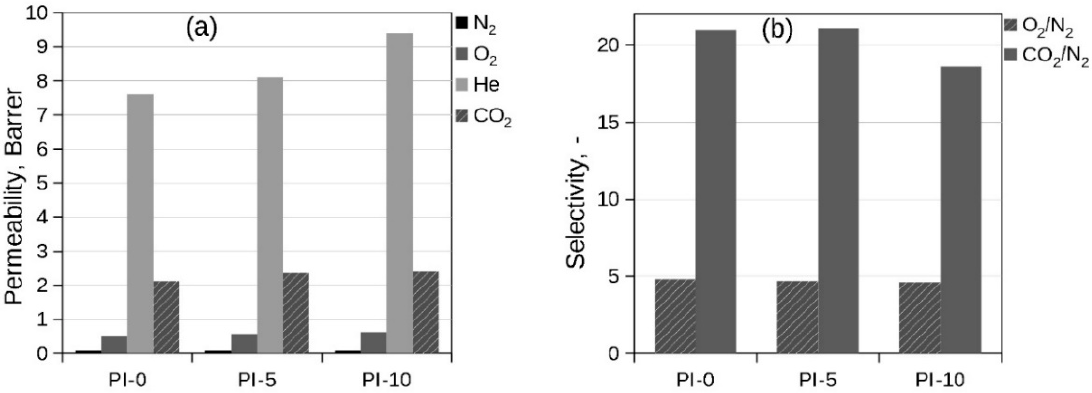
Figure 1. Dependence of the permeability ( a ) and the selectivity ( b ) of PI on silica content of 0% (PI-0), 5% (PI-5) and 10% (PI-10) [70].